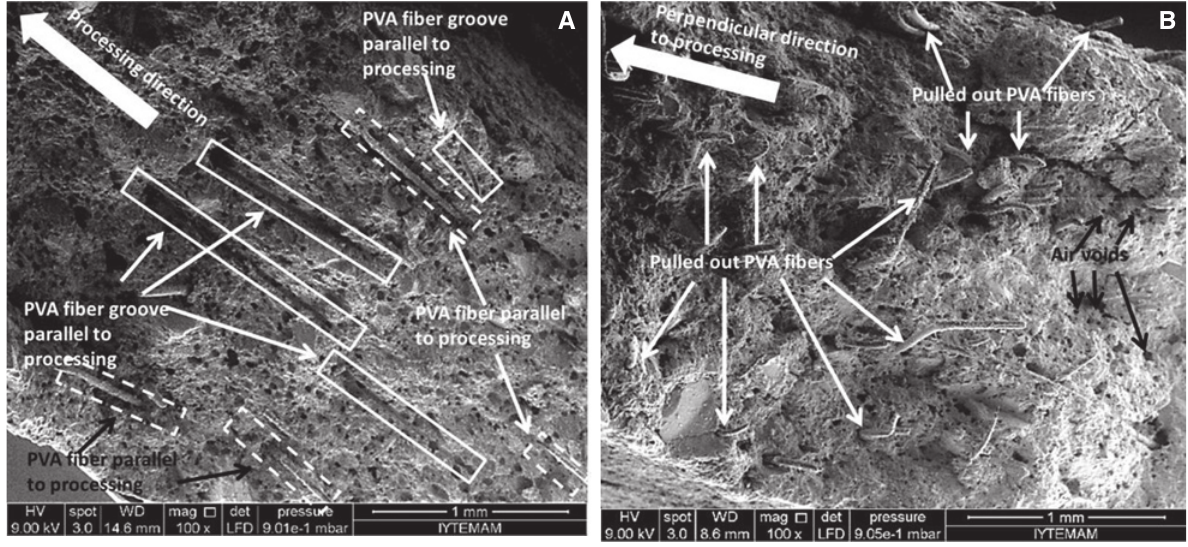
Figure 11 Post-tensile test SEM